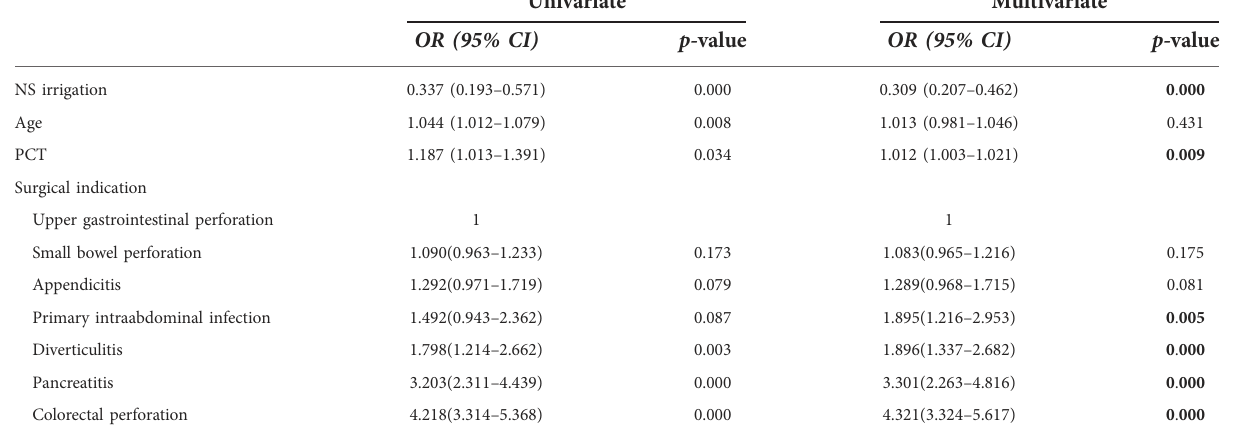
TABLE 3 Logistic regression analysis for surgical site